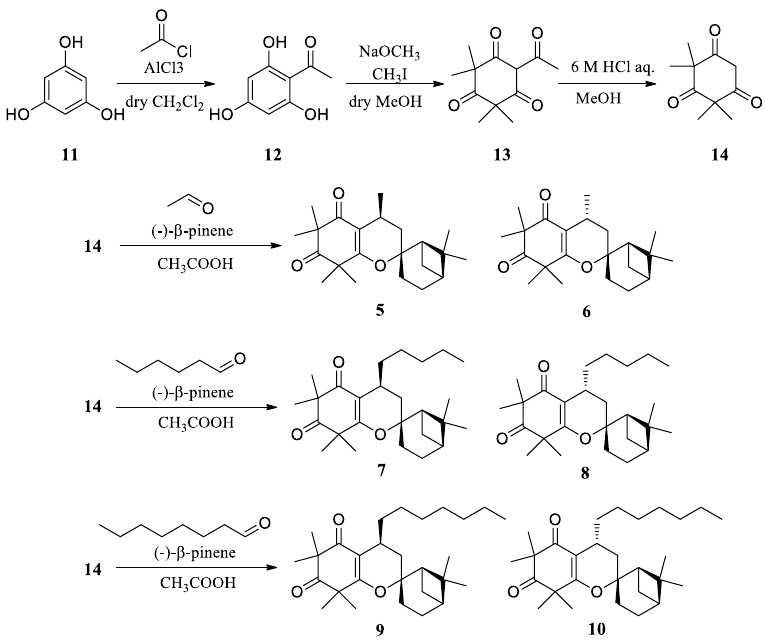
Figure 2. Synthetic scheme of ficifolidione derivatives containing an alkyl group instead of an isobutyl group at the C-4 position ( S -Me ( 5 ), R -Me ( 6 ); S - n -pentyl ( 7 ), R - n -pentyl ( 8 ); S - n -heptyl ( 9 ), and R - n -heptyl ( 10 )).